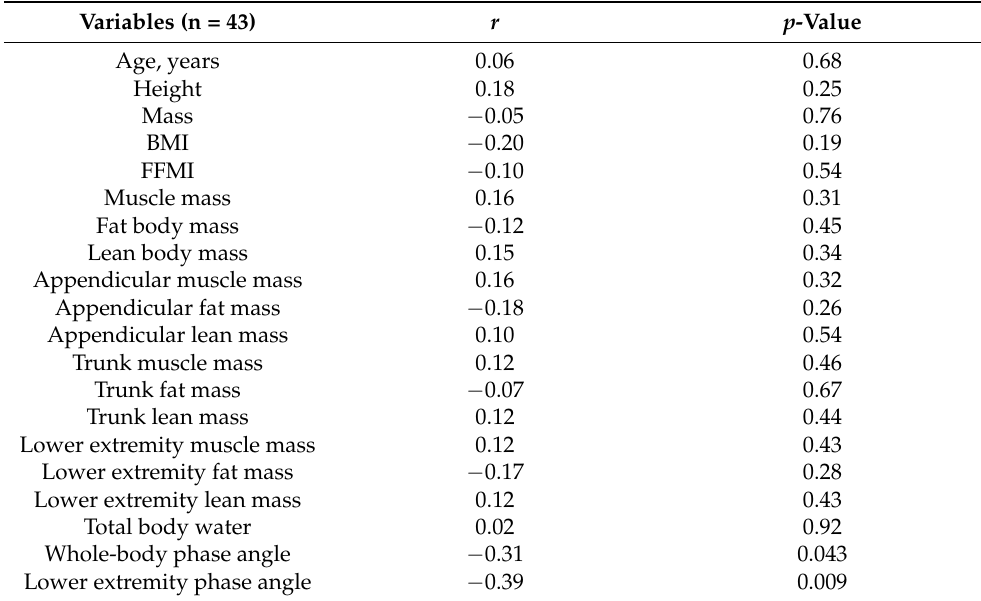
Table 3. Correlation analysis between McGS and the attribute, and body composition variables in the IDHS